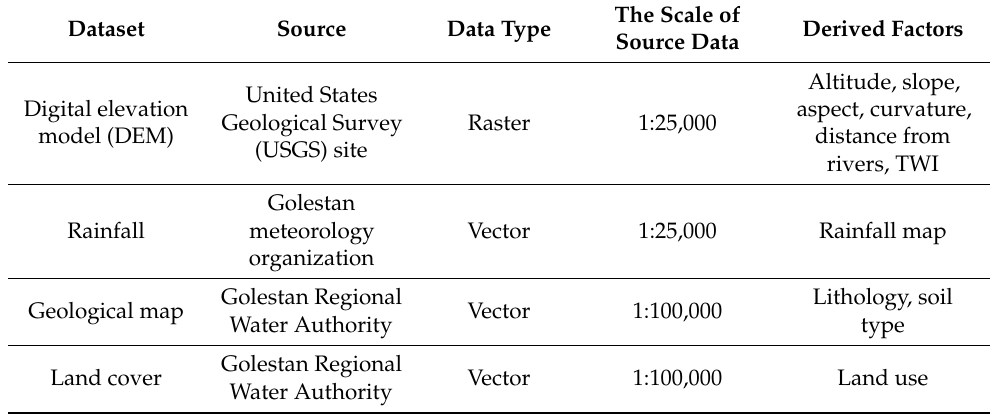
Table 1. Sources and types of the data